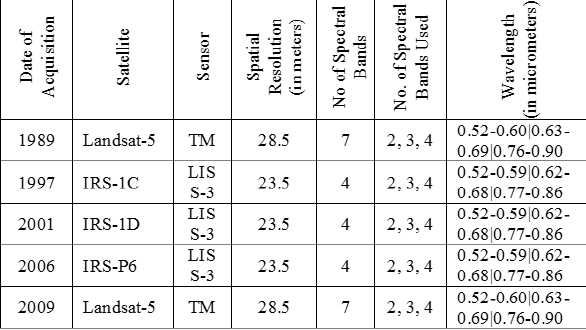
Table 1. Details of multispectral satellite imagery of Landsat and Indian Remote Sensing (IRS)